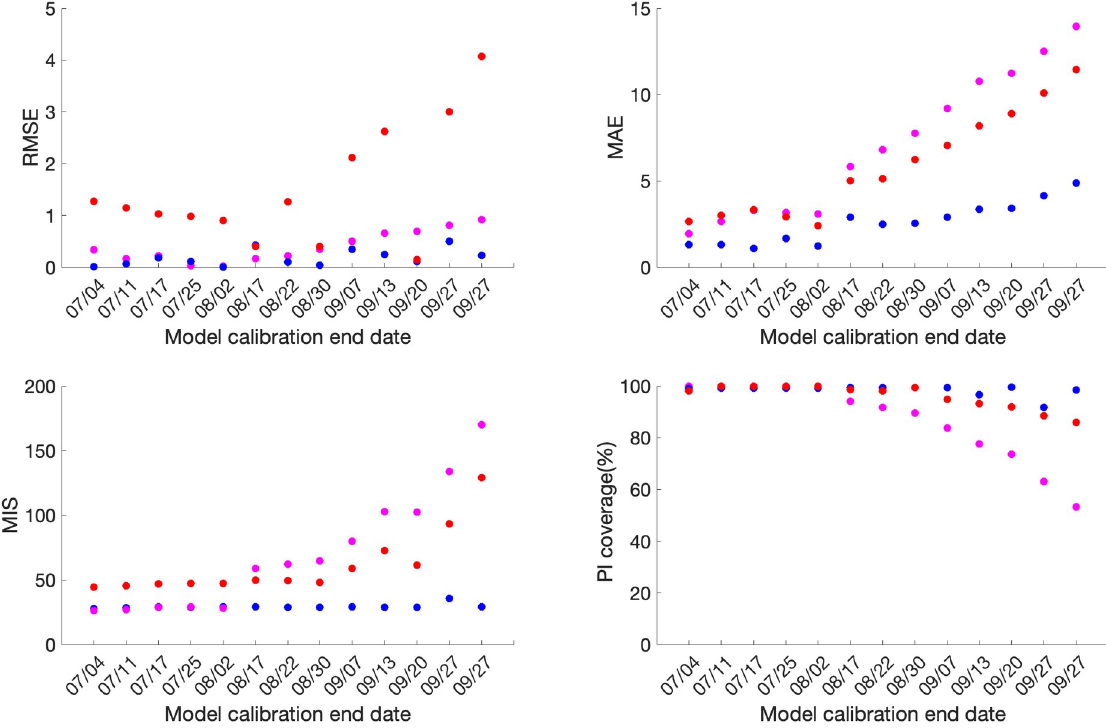
Fig 2. Calibration performance for each of the thirteen sequential calibration phases for GLM (magenta), Richards (red), and sub- epidemic (blue) model for Mexico. High 95% PI coverage and lower mean interval score (MIS), root mean square error (RMSE), and mean absolute error (MAE) indicate better